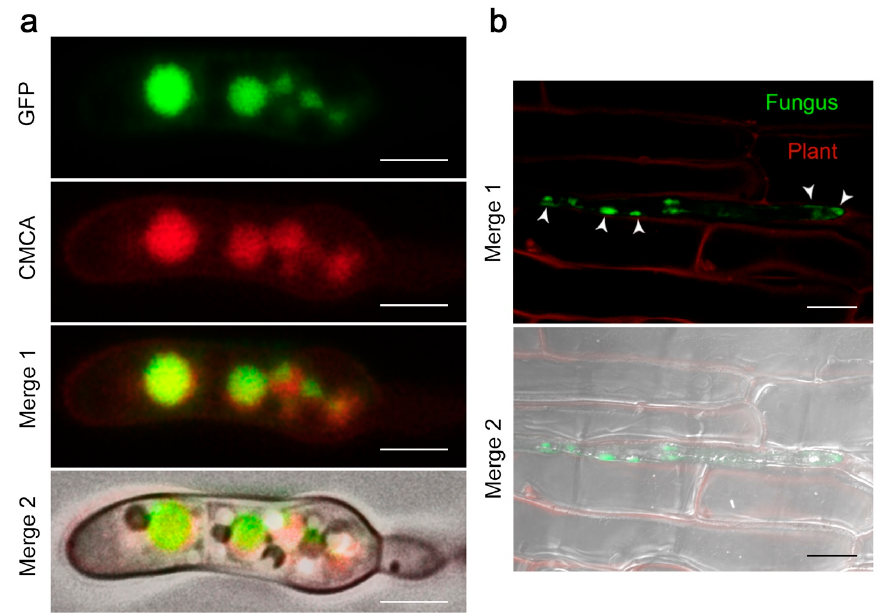
Figure 4. Subcellular localization of FocCP1. ( a ) Colocalization of vacuoles stained with CellTracker Blue (red) and FocCP1-GFP (green) in the conidia of ∆ FocCP1-C-GFP strain. Bar = 5 µm. ( b )